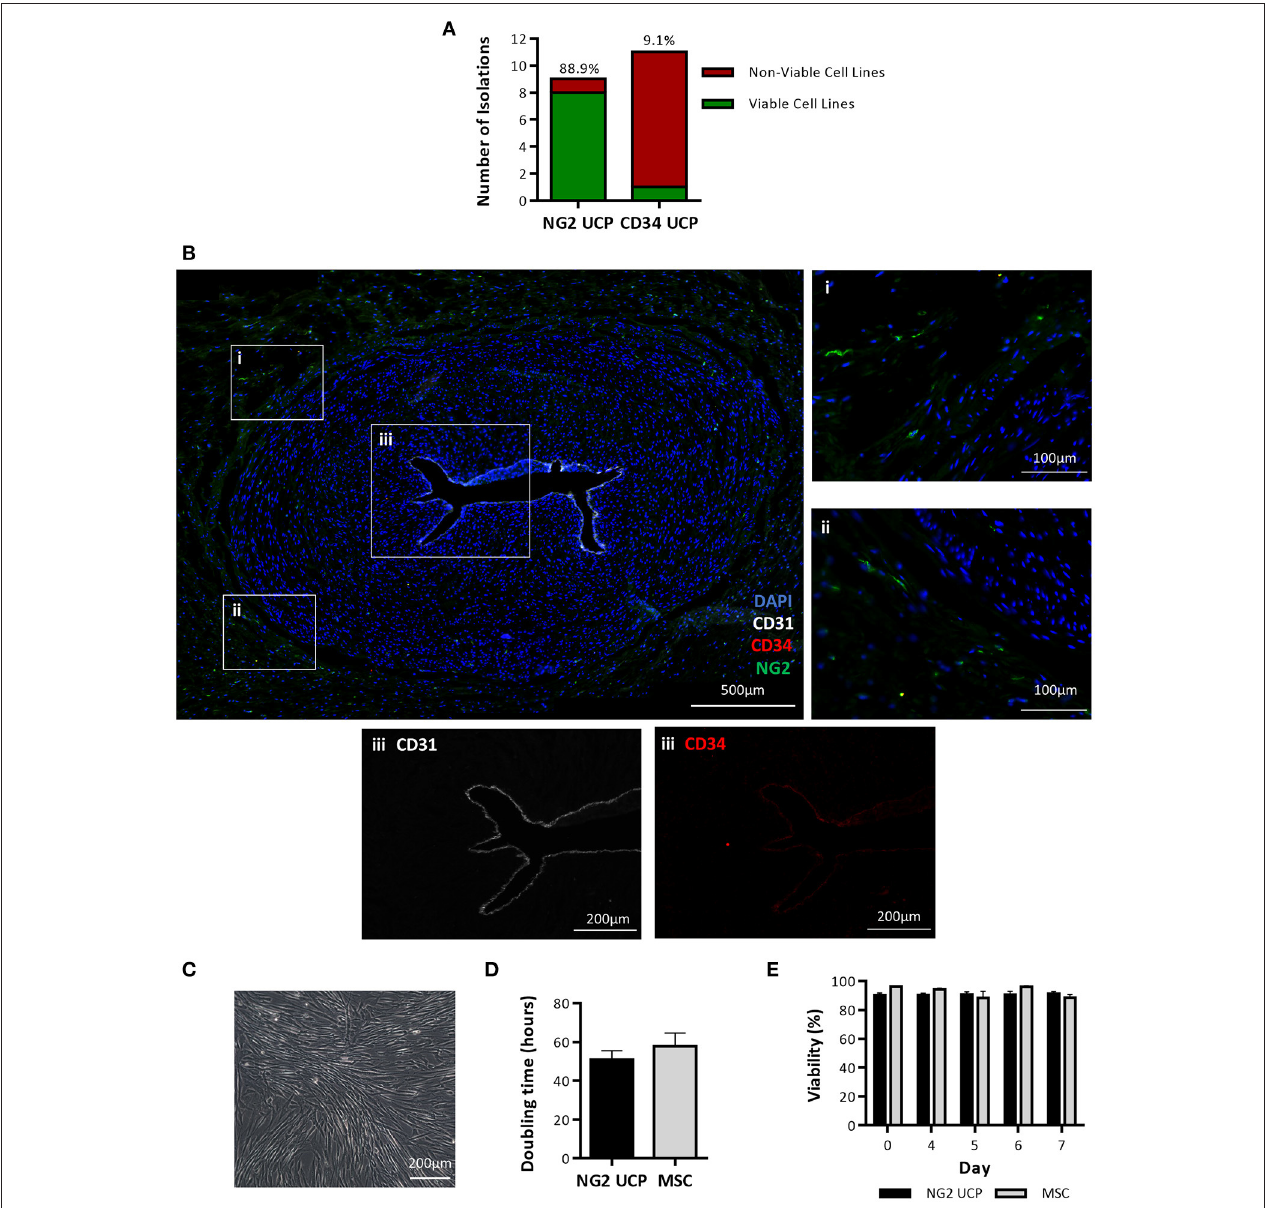
FIGURE 2 | Isolation and expansion of umbilical cord pericytes. (A) Successful and unsuccessful cell isolations from the umbilical cord using two immunomagnetic sorting methods based on NG2 and CD34 antigens. The percentage above each column indicates the efficiency of the isolation protocol. (B) Immunohistochemical staining of umbilical artery. DAPI, blue; CD31, white; CD34, red; and NG2, green. Inserts in (i, ii) show NG2 positive pericytes negative for CD31 and CD34. Insert III shows CD31 and CD34 expression is restricted to the endothelial layer in the lumen. (C) Morphology of NG2 UCPs. (D) Doubling time in culture, calculated from cell growth curve. (E) Viability analysis of cells in culture. Data represent means ( ± S.E.M). MSCs and NG2 UCPs, n = 3 and 6 biological replicates,